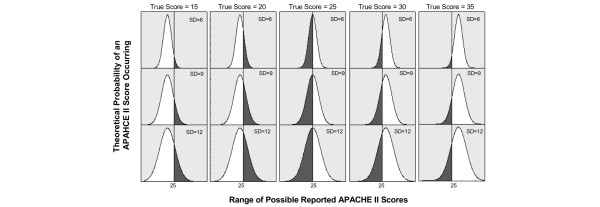
Theoretical distributions of APACHE II scores with varying SDs. A set of theoretical distributions of reported APACHE II scores based on standard deviations of 6 and 12 (which were what we observed in the case scenario data.) For the purposes of comparison, a set of curves using an intermediate standard deviation of 9 is also shown. In every curve, the shaded area illustrates the theoretical probability of misclassification based on a cut-off score of ≥25.